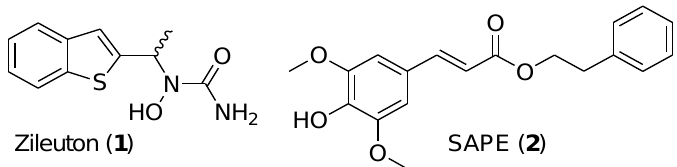
Figure 1. Structure of zileuton ( 1 ) and sinapic acid phenethyl ester (SAPE) ( 2 ).